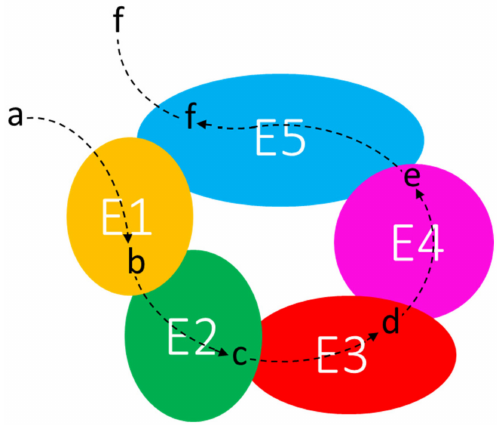
Figure 3. Channeling of metabolic intermediates through the enzymes of a supramolecular complex. E1–E5: enzymes; a–f: substrates and products of enzymatic